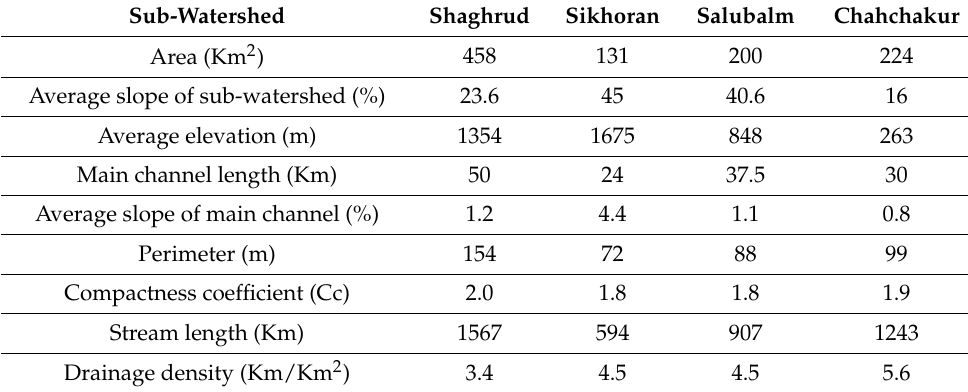
Table 1. Summary of general characteristics.